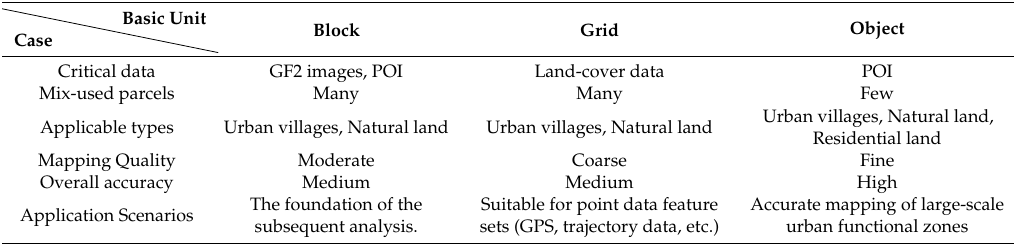
Table 8. Summary of di ff erent segmentation